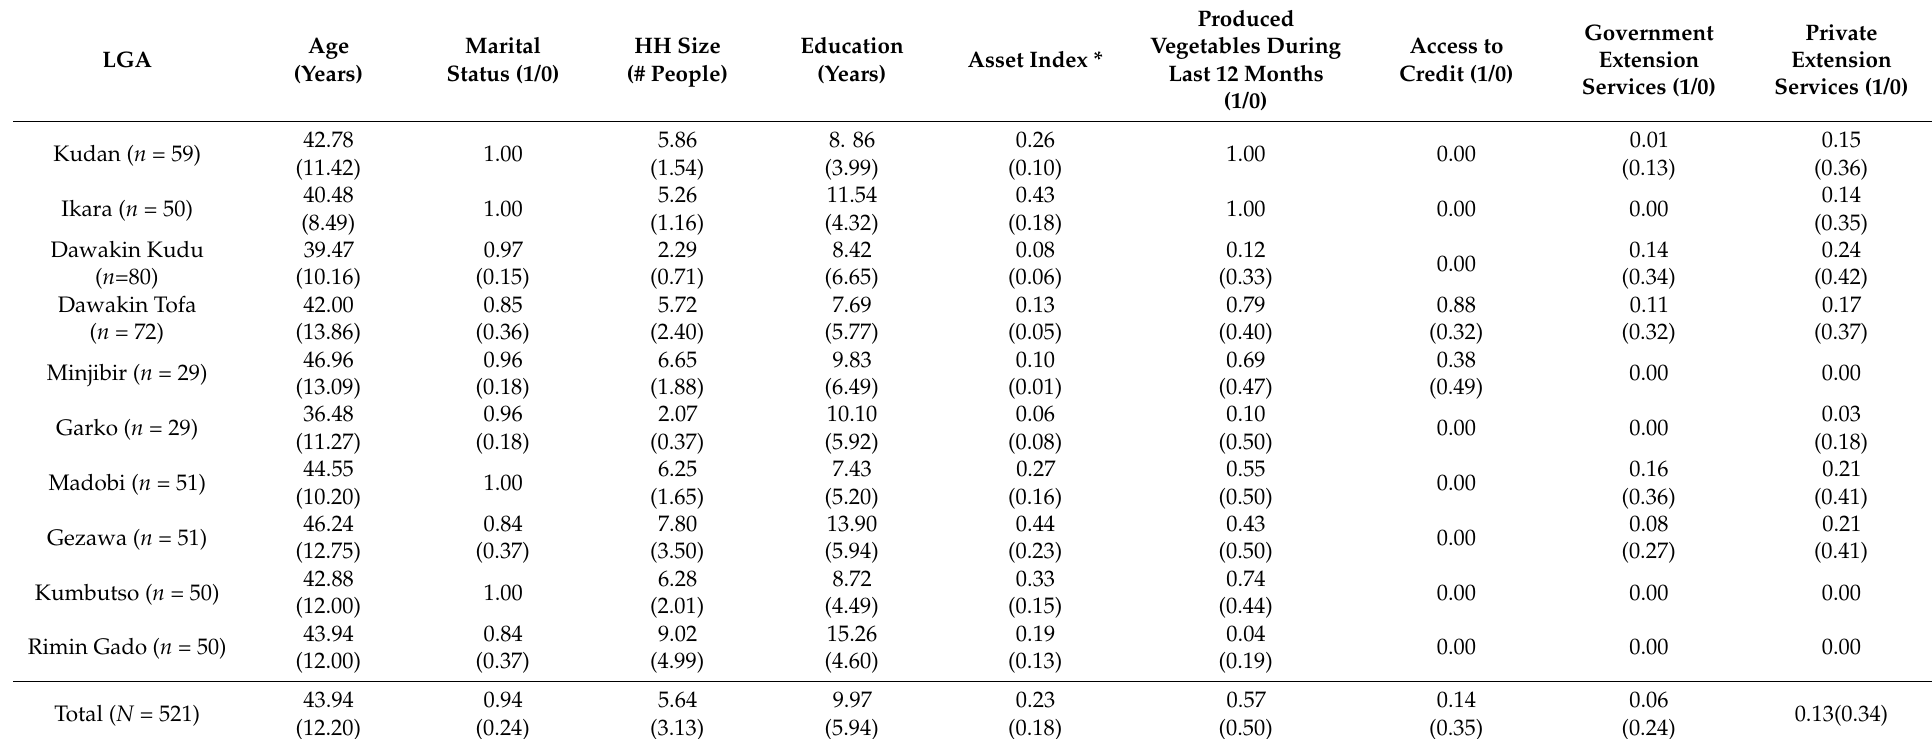
Table 2. Descriptive statistics of the respondents’ socio-economic